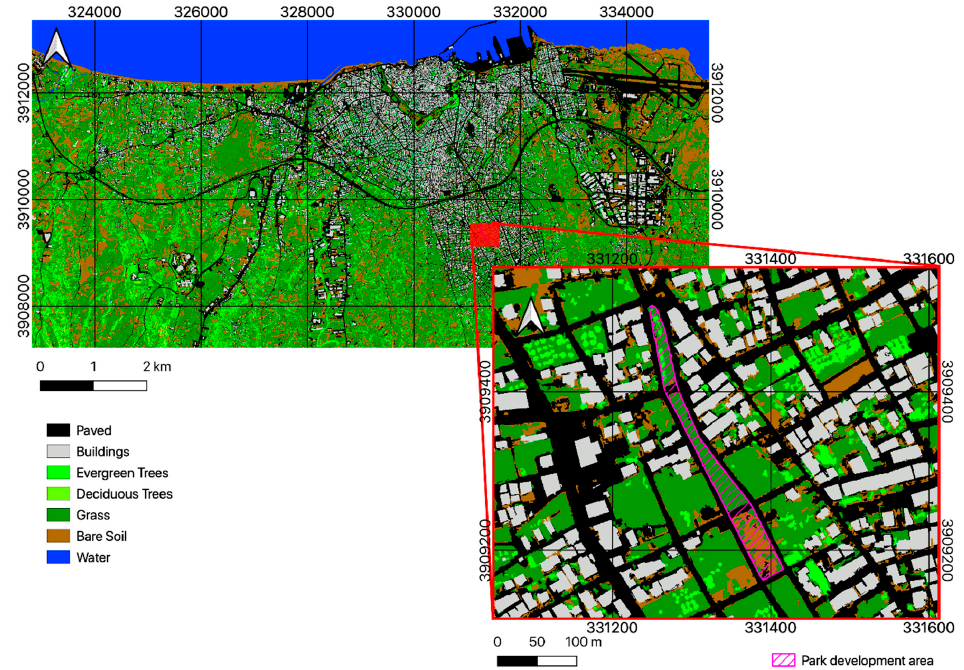
Figure 8. Surface cover map of Heraklion and the area of the park under the 7-class classification scheme (classification accuracy: 89.6%). scheme (classification accuracy: